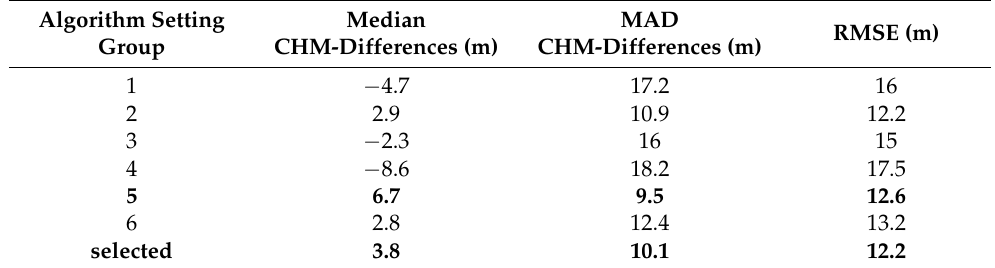
Table 6. Accuracy of GEDI-CHM estimates using the mean height value for ALS-CHM. Algorithm